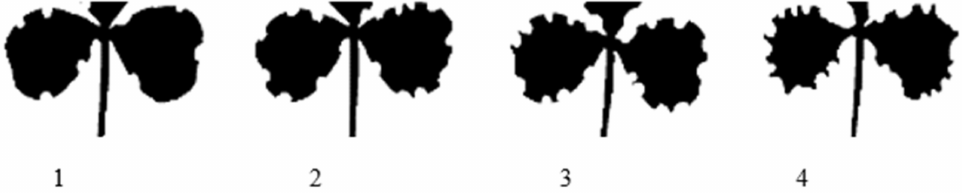
Figure 1. Images of cotyledon broad bean leaves showing damage from Sitona lineatus adults across rating scale. Rating scales of leaf damage: (1 = 1–10% of leaf margin with damage; 2 = 11–50%; 3 = 51–75%; 4 =